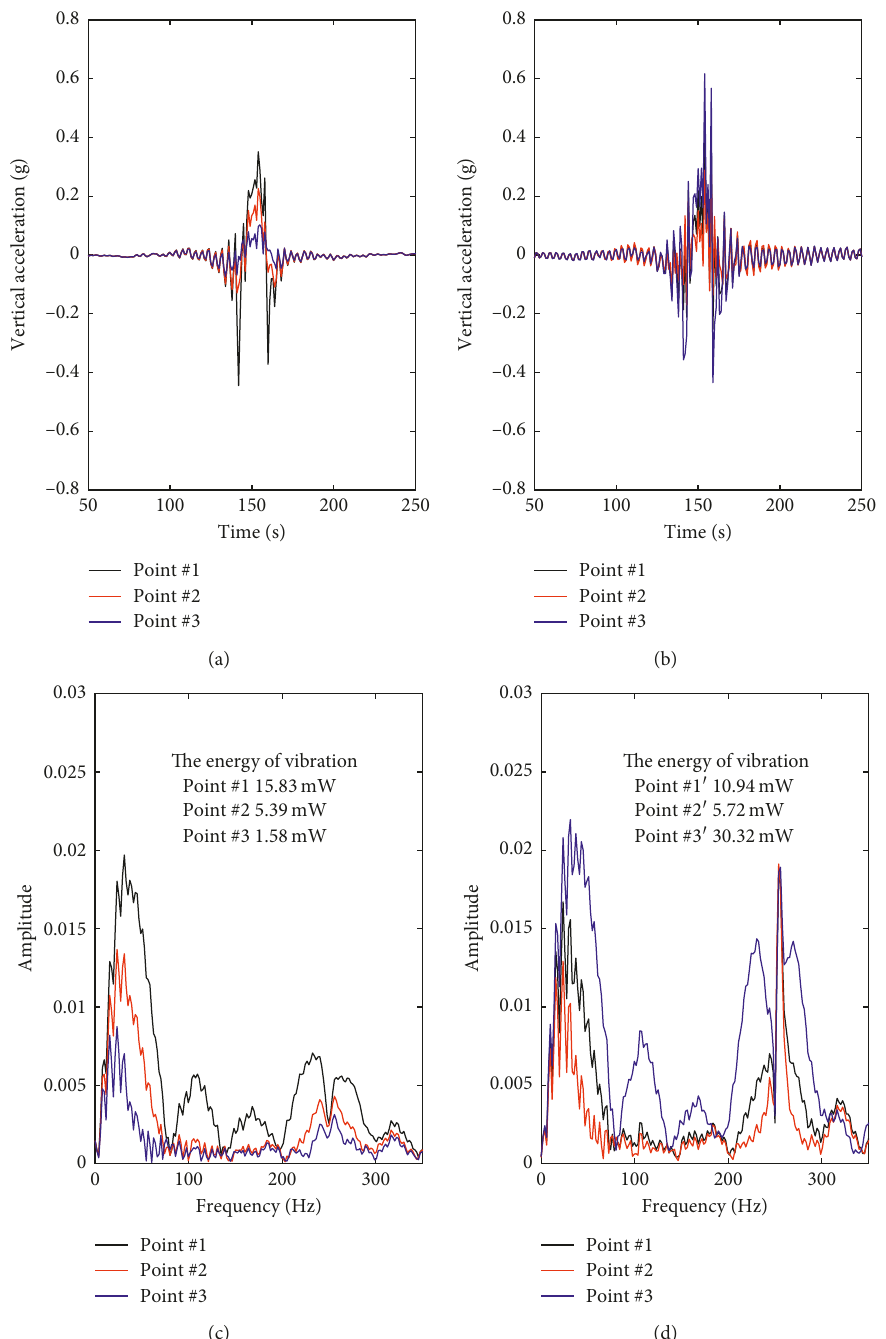
Figure 15: Comparison of the vertical acceleration signals of different structure integrity. (a) Time-domain vertical acceleration signals of asphalt concrete pavement with no crack. (b) Time-domain vertical acceleration signals of asphalt concrete pavement with crack. (c) Frequency-domain vertical acceleration signals of asphalt concrete pavement with no crack. (d) Frequency-domain vertical acceleration signals of asphalt concrete pavement with